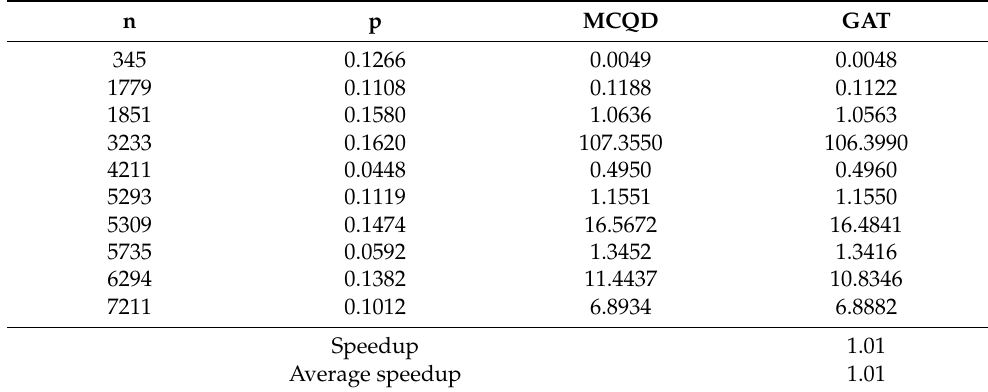
Table 7. Times that the MCQD algorithm and the MCQD-ML (variant with the GAT model) algorithm need to find the maximum clique for each graph from a test set of weighted molecular docking